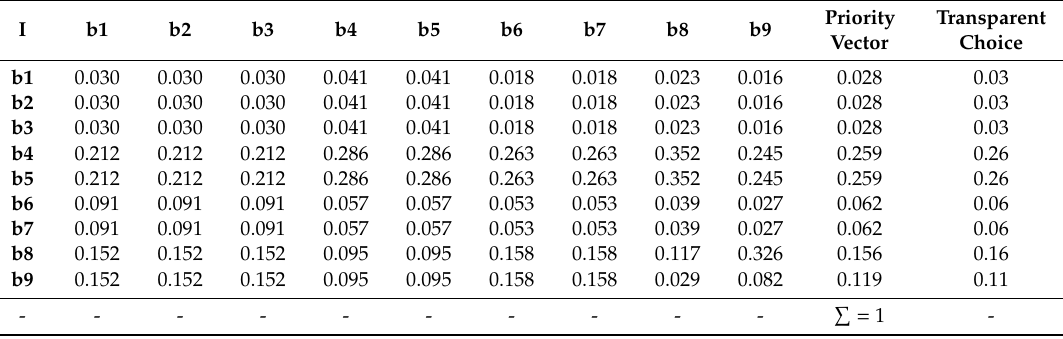
Table A6. Synthesised matrix for subcriteria associated with individual barriers.